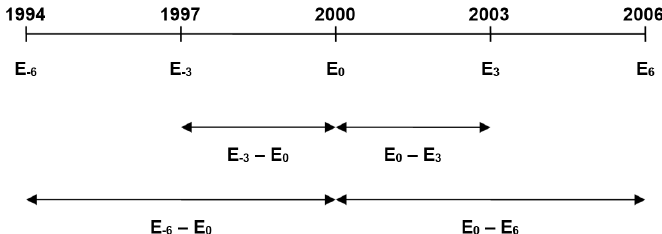
Figure 1. Schematic picture of the time periods over which the change in energy efficiency has been measured in certified and non ‐ certified companies (E − 6 = energy efficiency in 1994, six years before the base year 2000; E − 3 = energy efficiency in 1997, three years before the base year 2000; E 0 = energy efficiency in the base year 2000; E 3 = energy efficiency in 2003, three years after the base year 2000; E 6 = energy efficiency in 2006, six years after the base year 2000).